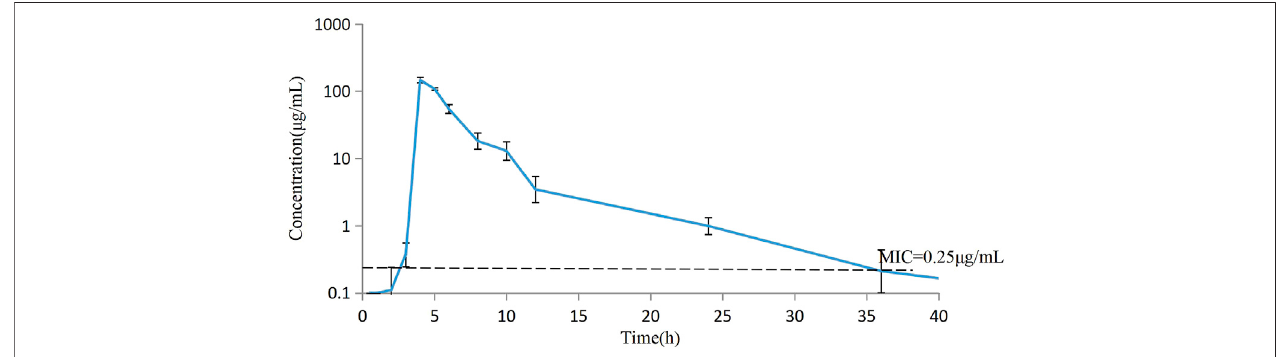
FIGURE 3 | Mean concentration versus time curves for avilamycin in ileal content after oral administration at a dose of 4 mg/kg b.w. ( n = 6).